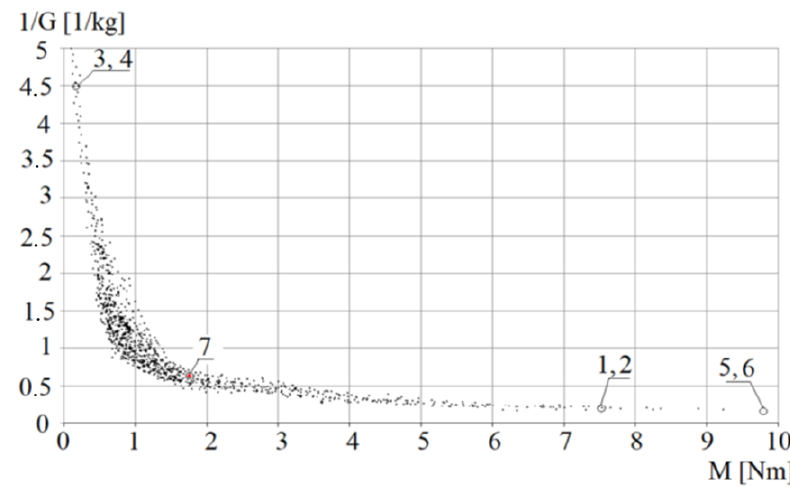
Figure 20. Optimization results on the background of the Pareto chart: 1 — F Gmin , 2 — F G1min , 3 — F Pmin ,